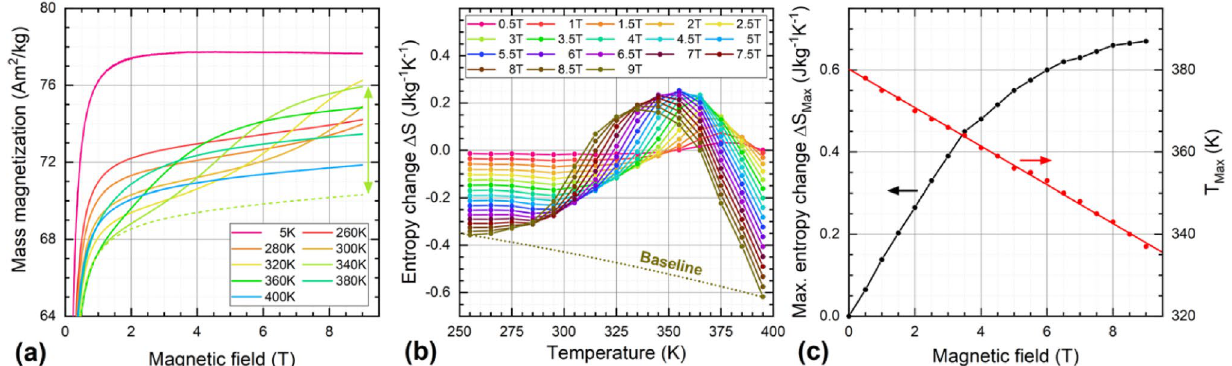
Figure 5. ( a ) Field-dependent magnetization curves recorded at 5—400 K in magnetic fields up to 9 T showing the field-induced AFM-FM phase transition, the dashed line is a guide to the eye extrapolating the curve at 340 K in the absence of the phase transition, ( b ) entropy change ΔS extracted from ( a ), the dotted line represents a background component related to the temperature-dependent decrease in high-field magnetization, ( c ) maximum entropy change ΔS MAX (black), and shift in maximum position T Max (red).